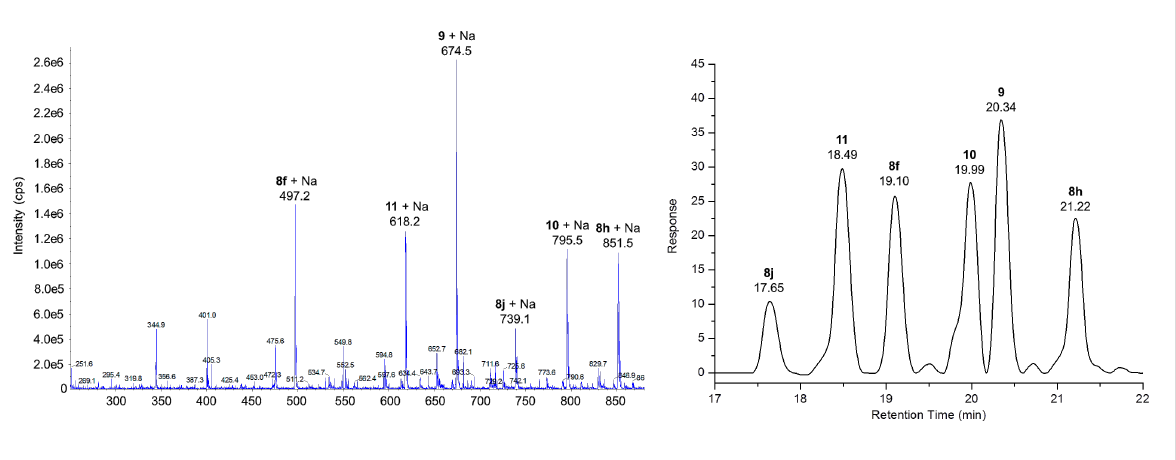
Figure 2: Expanded region of the ESI-MS spectrum (positive mode) and the HPLC chromatogram of the crude mixed library of 1,3-diyne peptoids ( 8f , 8h , 8j , 9 , 10 and 11 ) produced by a combinatorial Glaser coupling of three different monomers (see Scheme 1).